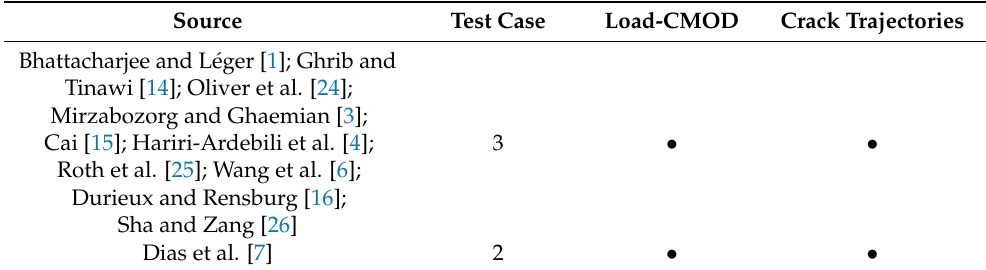
Table 3. Benchmark information considering smeared crack and enhanced finite elements. Source Test Case Load-CMOD Crack